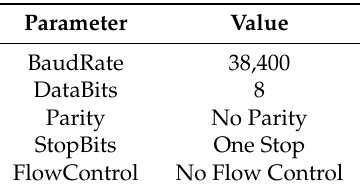
Table 2. Configuration of the serial communication.